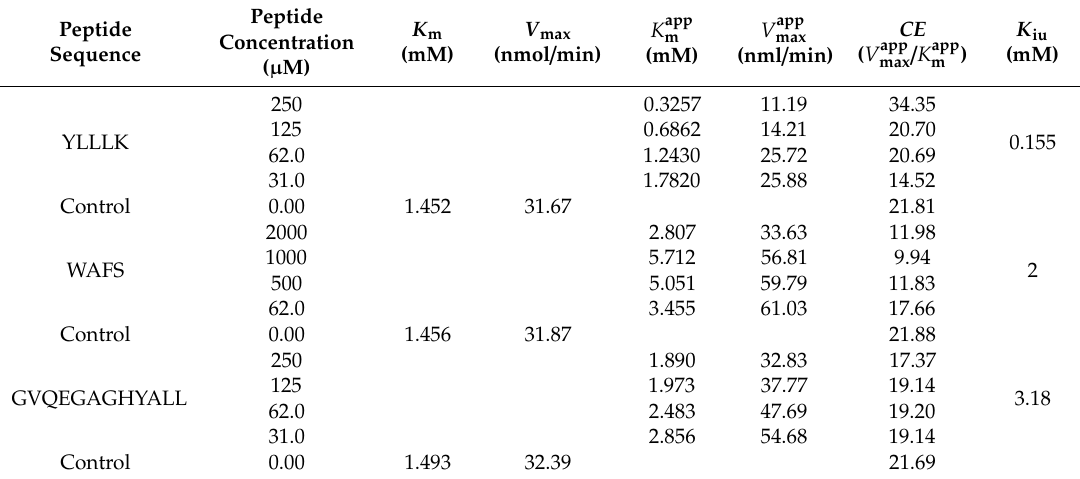
Table 4. V max , K m of ACE inhibited by peptides along with its K iu and CE.